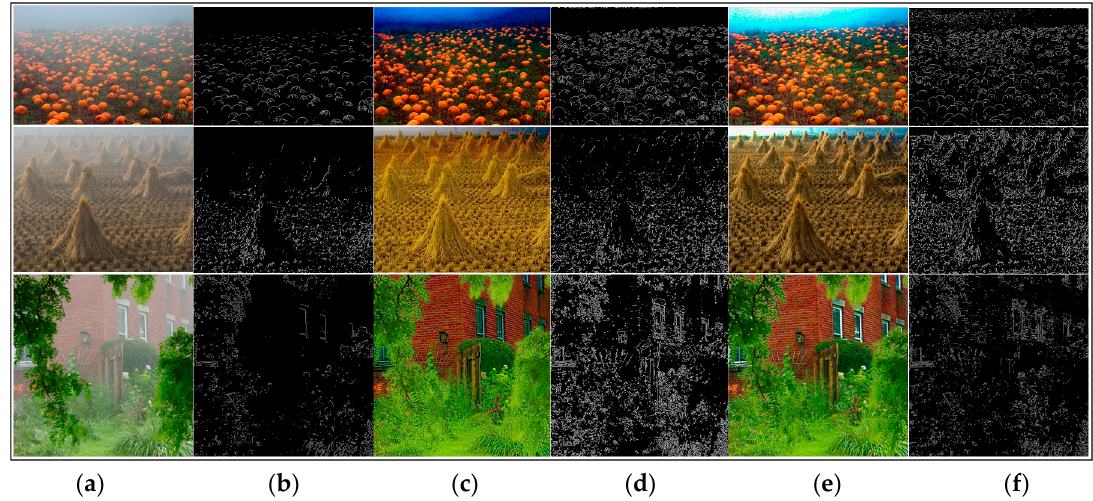
Figure 7. Comparison of our method to the method by Nishino [14] using real-world images. ( a , b ) input hazy images and their corresponding visible edges, respectively; ( c – f ) are the dehazing results with corresponding visible edges generated by the method of Nishino [14] and ours, respectively.